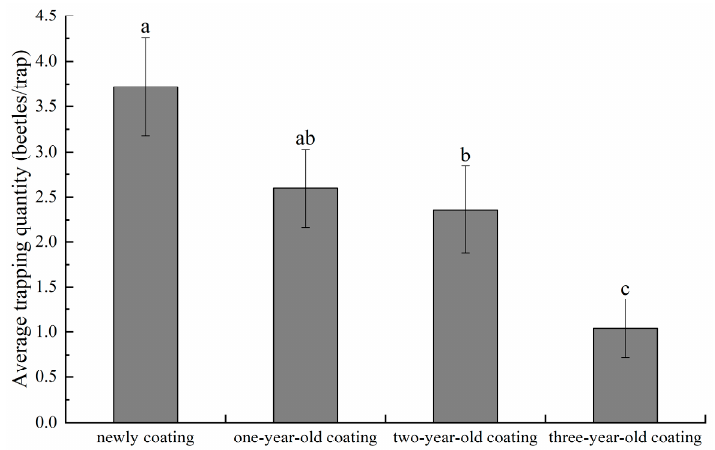
Figure 3. Effect of the duration of exposure of Teflon-coated traps on trapping of Monochamus alternatus in Fuyang. Different letters on bar top indicate significant differences between treatments. ( α = 0.05).